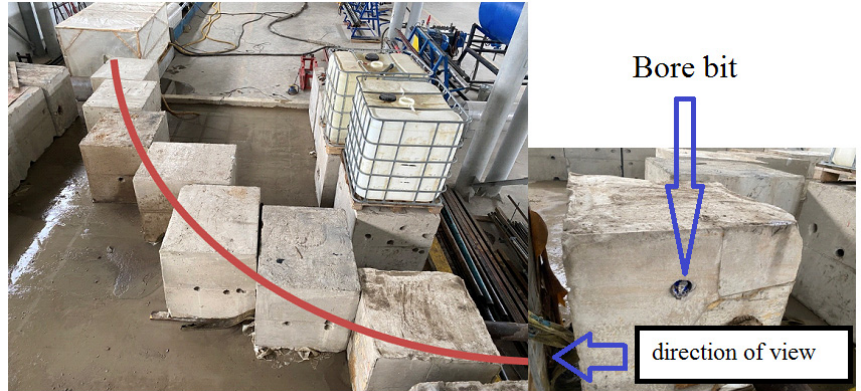
Figure 2. Bench tests of TS while drilling a channel with curvature radius of 7.7 m.